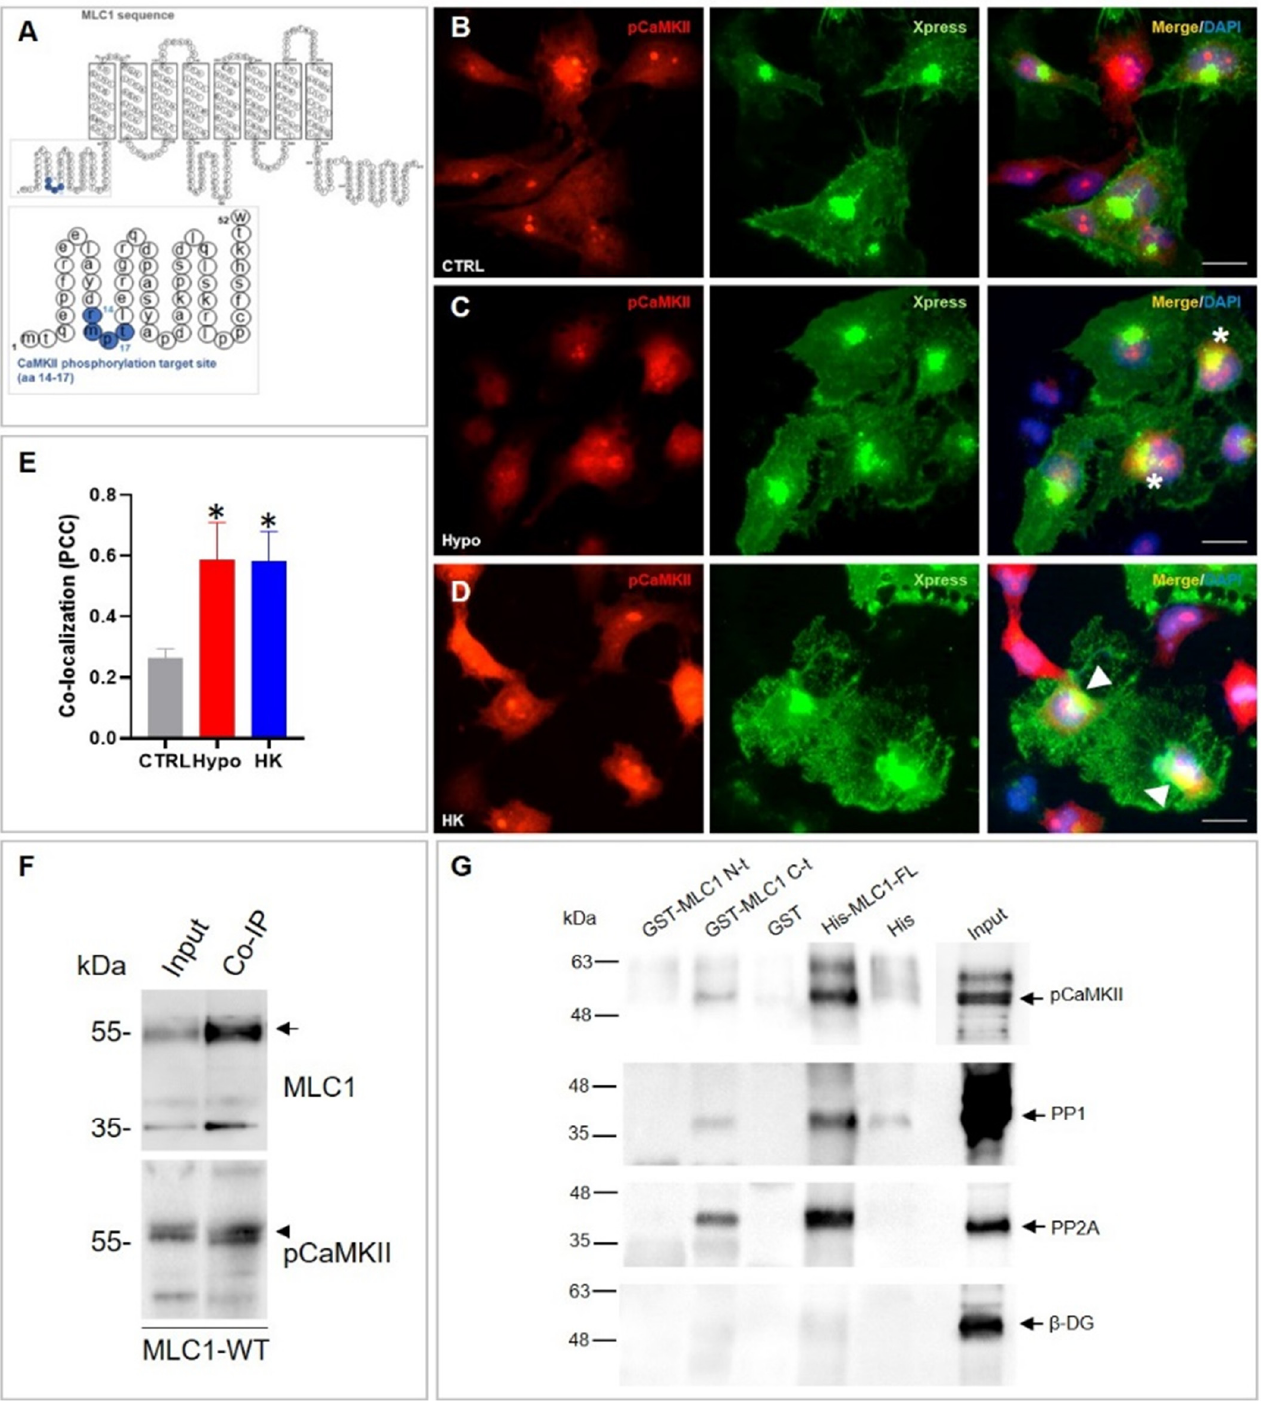
Figure 1. CaMKII binds the MLC1 protein in U251 cells. ( A ) Schematic representation of MLC1 protein sequence showing a potential CaMKII phosphorylation target site in the MLC1 NH 2 terminal (aa 14–17). ( B – D ) IF staining of MLC1-WT U251 cells with anti-phospho (p)CaMKII pAb (red) in combination with anti-Xpress mAb (green) to detect the Xpress tag localized in the MLC1 NH 2 terminal shows low levels of pCaMKII expression in the cytosol of U251 cells in control conditions (CTRL, ( B) ) and an increase of its expression and a partial colocalization with MLC1 in the perinuclear areas after a 30-min treatment with hyposmotic (Hypo) and high K + (HK) solutions (asterisks and arrowheads in ( C , D ), respectively). Scale bars: 20 µm. Panel ( E ) shows the quantification of the colocalization signal (yellow) evaluated using ImageJ software. The degree of colocalization was estimated using the Pearson correlation coefficient (PCC). Data are shown as means ± SEM of